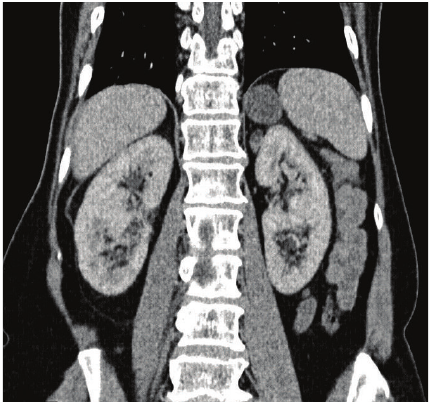
Figure 2: Six months after the spontaneous rupture of the angiomy- olipoma (AML) on the left kidney, control CT showed the complete regression of the retroperitoneal hematoma and a well-delineated AML.